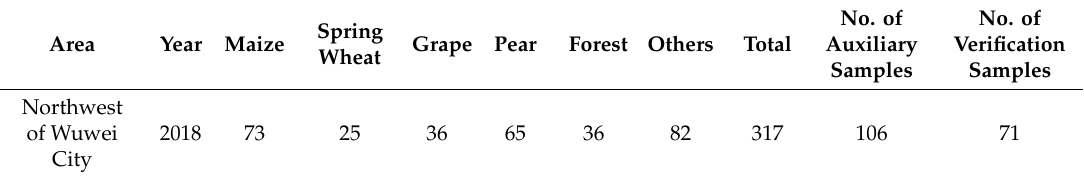
Table 11. Details of the ground reference samples.